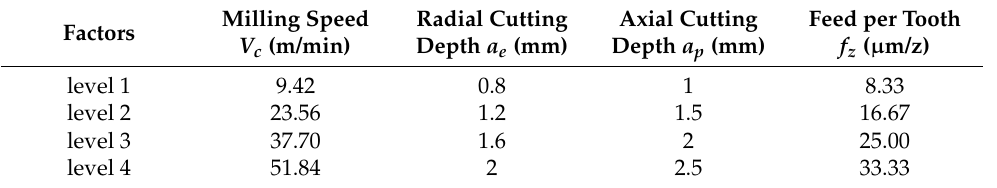
Table 2. The single-factor experiments on the milling